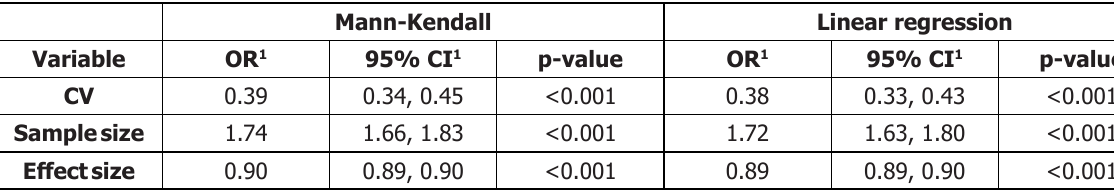
Table 1. GLMs for probability of adequate statistical